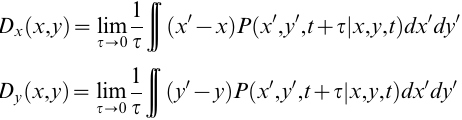
Figure S1 Probability density distributions. The position and velocity axes are indicated in the lower right panel, and the extracted 3-bin summed probability values are provided for each distribution. (A) Probability density distributions of model simulations in the mono-stable regime (upper panel) and limit cycle regime (lower panel) at 0.5 Hz, 2.0 Hz, and 3.5 Hz (left, middle, and right column, respectively). The cycle period always corresponds to the required frequency except for the mono-stable regime at 3.5 Hz, due to a period doubling. (B) Probability density distributions of the data of one participant in the discrete, natural, and smooth condition (upper, middle, and lower row, respectively) at 0.5 Hz, 2.0 Hz, and 3.5 Hz (left, middle, and right column, respectively). Figure S2 Symmetry ratios in the mono-stable regime. The symmetry ratio of the simulated data in the mono-stable regime is presented as a function of parameter b and frequency. Figure S3 Spectral power in the mono-sable regime. The amount of spectral power in the mono-stable regime as a function of parameter b and frequency at the sub-harmonic (P[ v /2]) (left panel), the fundamental frequency (P[ v ]) (middle panel), and the first super-harmonic (P[2 v ]) (right panel). Figure S4 Symmetry ratios of the human data. The average symmetry ratio for the participants (n = 8) adopting a ‘discrete’ motor solution (D; n = 4) and a ‘smooth’ motor solution (S; n = 4) in the natural condition as a function of frequency for the natural, discrete, and smooth condition (left, middle, and right panel, respectively). The vertical bars indicate standard deviations. Figure S5 Spectral power in the human data. The amount of spectral power in the human data as a function of instruction condition and frequency at the sub-harmonic (P[ v /2]) (left panel), the fundamental frequency (P[ v ]) (middle panel), and the first super-harmonic (P[2 v ]) (right panel). For the natural conditions, the data for the participants who adopted the ‘discrete’ and ‘smooth’ condition (Nd and Ns, respectively) are depicted separately, whereas for the discrete and smooth condition thee data are collapsed across both groups. Figure S6 Goal frequency versus observed frequency. Note that in conditions where participants were slowing down, the observed 7 April 2008 | Volume 4 | Issue 4 |